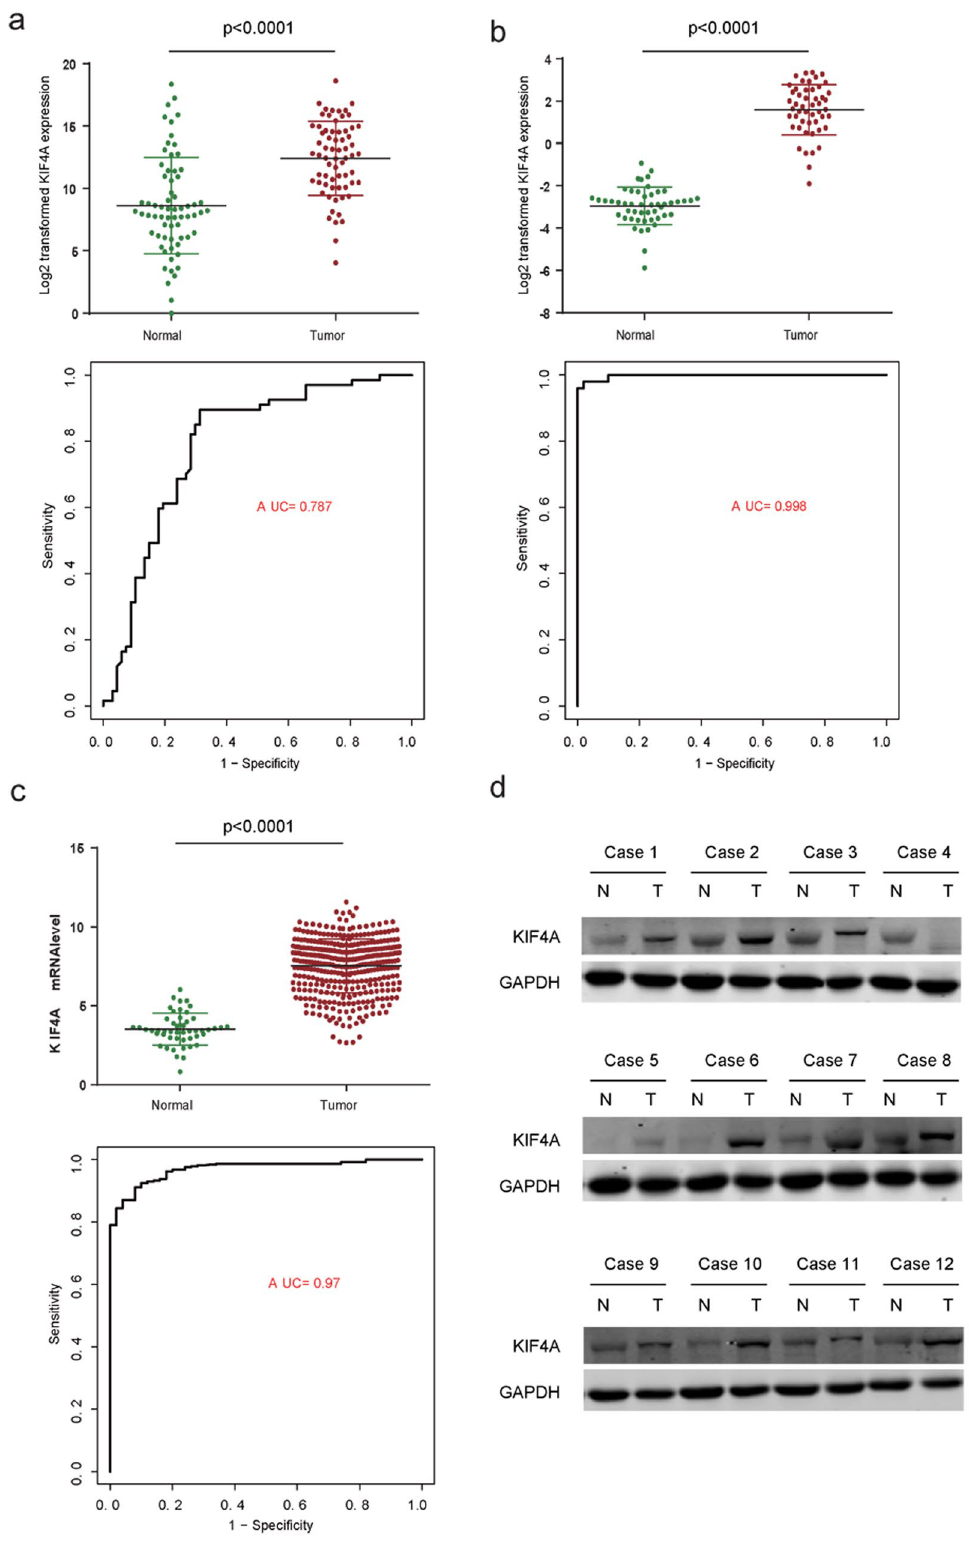
Figure 1. The diagnostic effect of KIF4A in HCC. The mRNA expression level of KIF4A is up-regulated in tumor tissues compared to the normal in ( a , top panel) Real time PCR in 67 pair tumor vs normal tissues ( b , top panel). RNA sequence of 50 pair tumor vs normal tissues and ( c , top panel) RNA-seq of unpaired tumor vs normal tissues in TCGA liver cancer; respectively, the diagnostic effect of KIF4A were evaluated by ROC curve in three datasets ( a – c , bottom panel). The protein expression level of KIF4A is up-regulated in tumor tissues compared to the normal in ( d